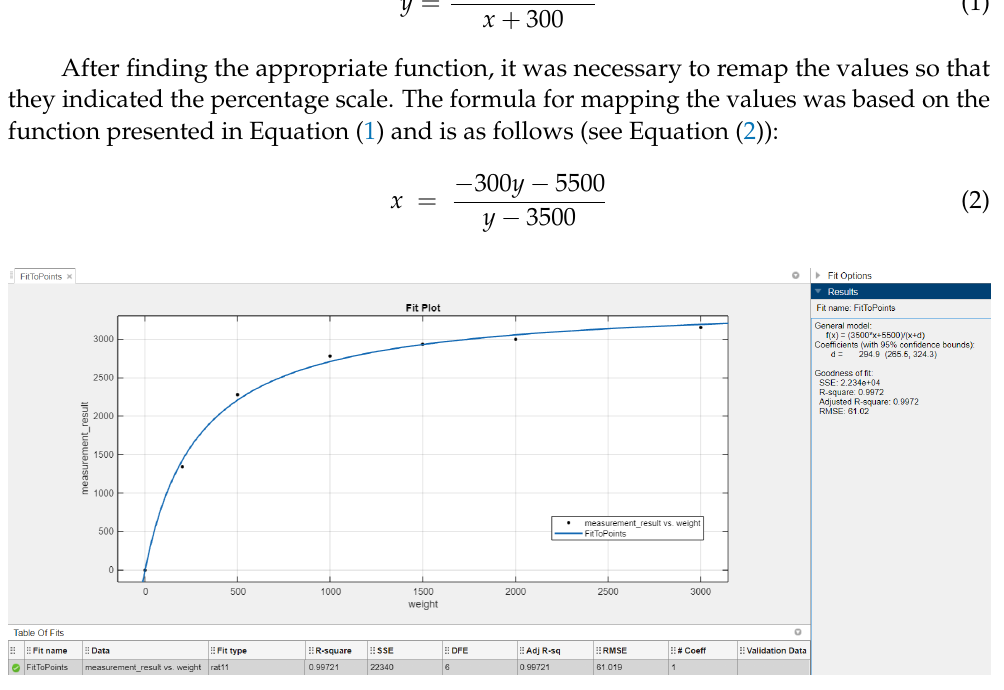
Figure 7. Curve Fitting Tool: Function